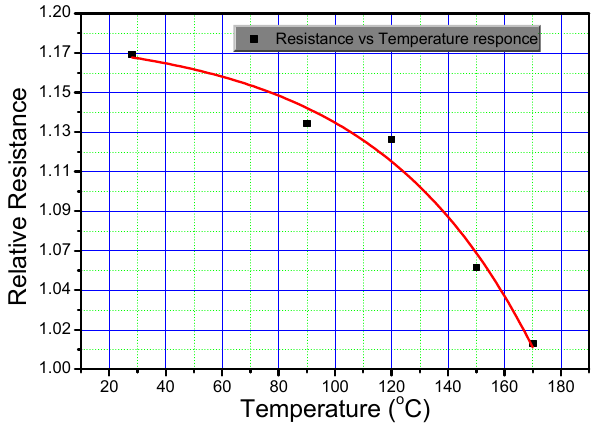
Figure 5. Resistance and temperature interdependence of organic-inorganic hybrid composite film.